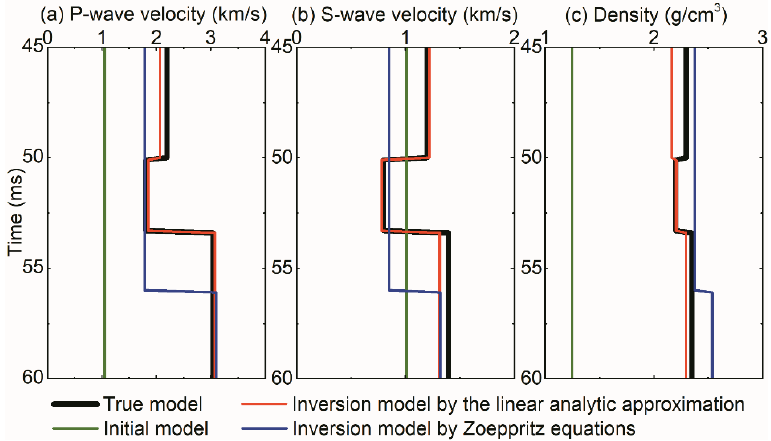
Figure 7. Inversion results of Model 3 by the linear analytic approximation and Zoeppritz equations: ( a ) P-wave velocity; ( b ) S-wave velocity; ( c ) density.